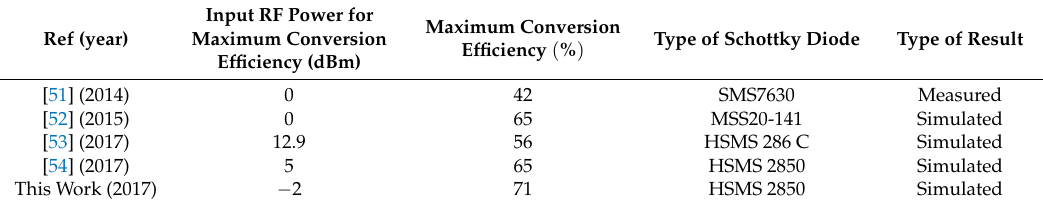
Table 6. Comparison of the proposed rectenna and related designs.